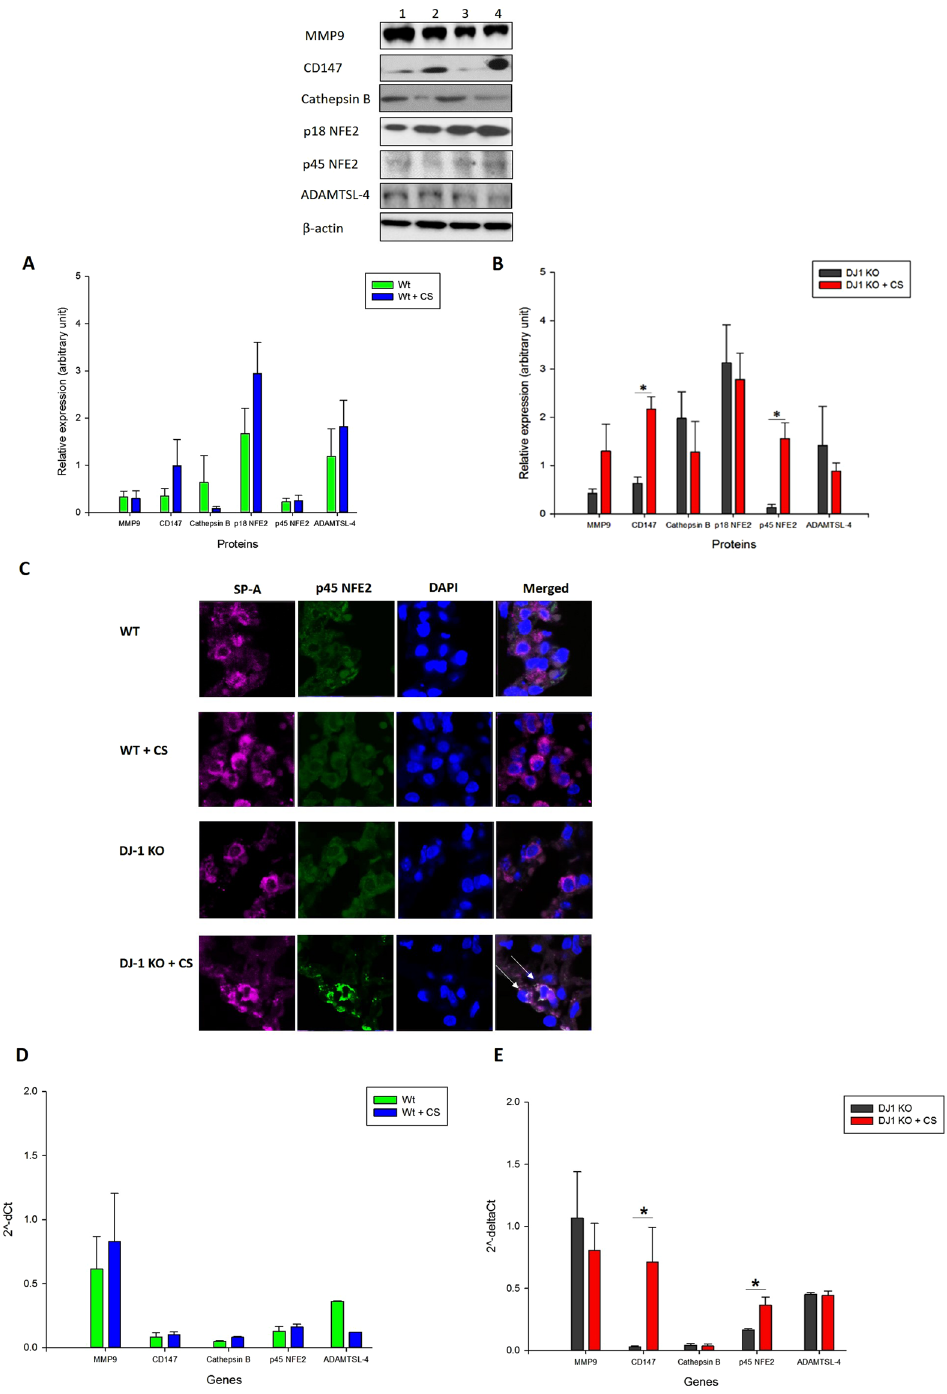
Figure 5. MMP9, CD147, cathepsin B, p18 NFE2, p45 NFE2 and ADAMTSL-4 expression in wild-type and DJ-1 KO mice. Wild-type (WT) ( A ) and DJ-1 KO mice ( B ) were exposed to 150 mg/m 3 cigarette smoke (CS) for 2 h/day for 3 weeks as described in Materials and Methods section. Protein levels were analyzed in lung tissue by Western blotting. Lane 1 – WT mice, Lane 2 – WT + CS, Lane 3 – DJ-1 KO mice, Lane 4 – DJ-1 KO mice + CS. Relative expression is also shown. ( C ) p45 NFE2 expression (green) in ATII cells identified using SP-A antibody (violet) in lung tissue obtained from wild-type and DJ-1 KO mice by immunohistofluorescence. Cell nuclei were stained with DAPI (blue). ( D , E ) MMP9, CD147, cathepsin B, p45 NFE2 and ADAMTSL-4 mRNA expression in lung tissue from wild-type ( D ) and DJ-1 KO ( E ) mice by RT-PCR. The strongest p45 NFE2 expression is indicated by white arrows. * Statistically significant difference in comparison with control ( p < 0.05). Data are shown as the mean ( ±